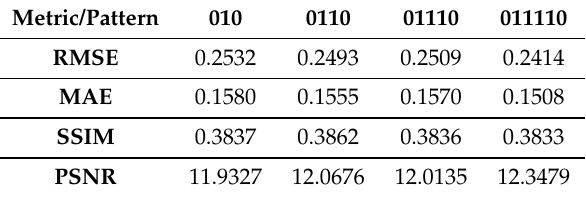
Figure 6. Mean green chromatic coordinate (GCC) time series and correlation results for Aspidosperma tomentosum and Caryocar brasiliensis individuals, considering original and foveal images with each model. Table 1. Results for reconstructed images using the four models respective to the 010, 0110, 01110, and 011110 binary patterns. The considered metrics are root mean squared error (RMSE), mean absolute error (MAE), structural similarity index (SSIM), and peak signal-to-noise ratio